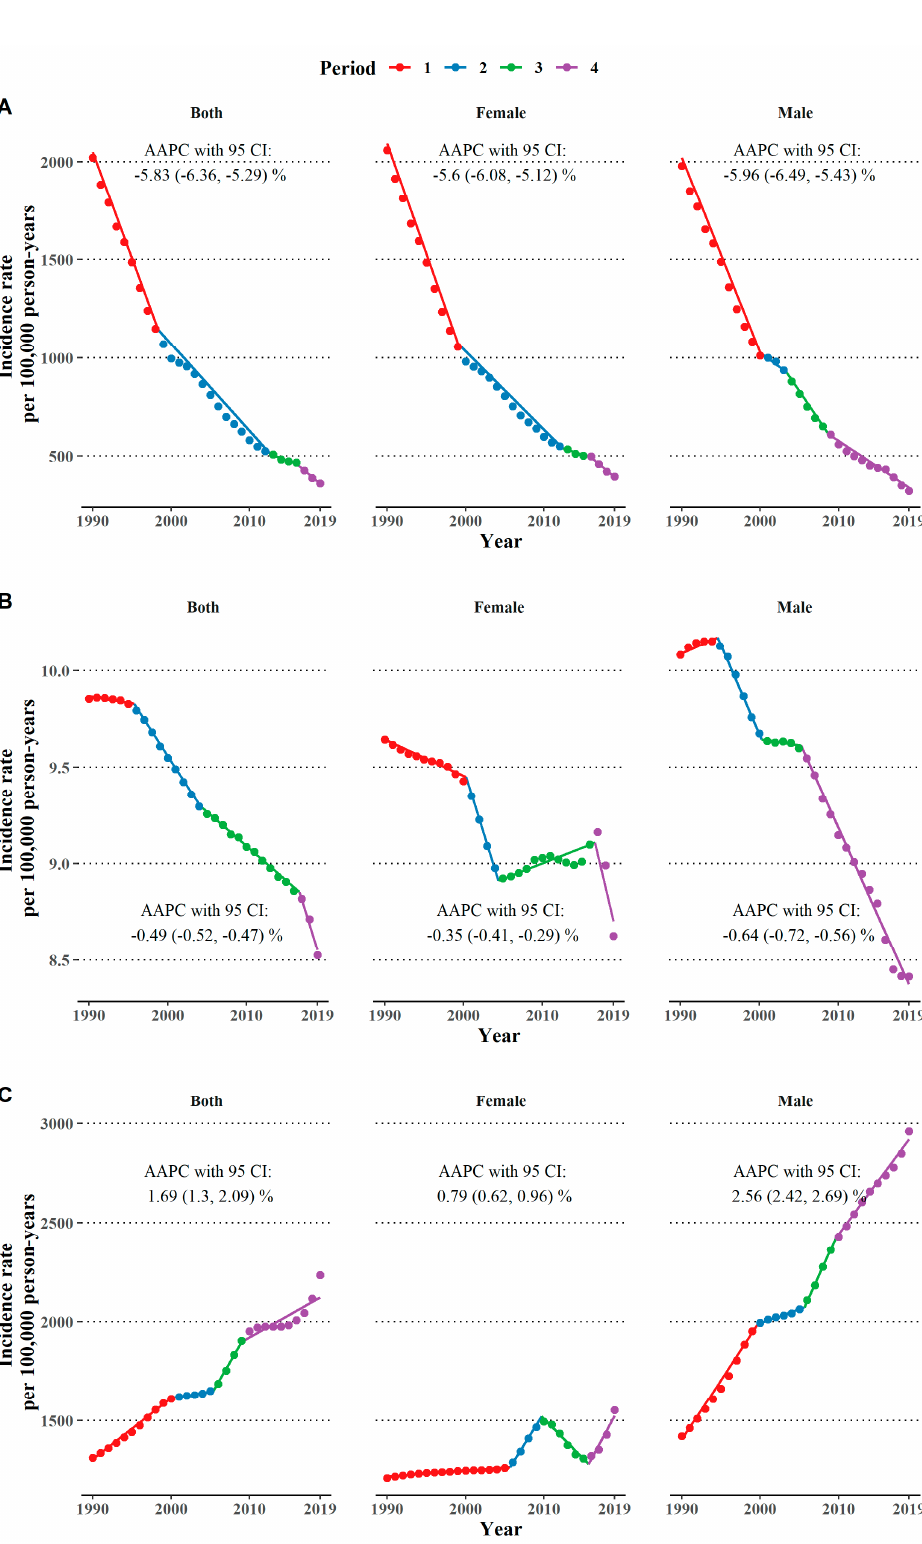
Figure 1. Trends in age-standardized incidence rate per 100,000 person-years of ( A ) vitamin A deficiency, ( B ) iodine deficiency, and ( C ) protein–energy malnutrition among the elderly in China from 1990 to 2019, as stratified by sex.